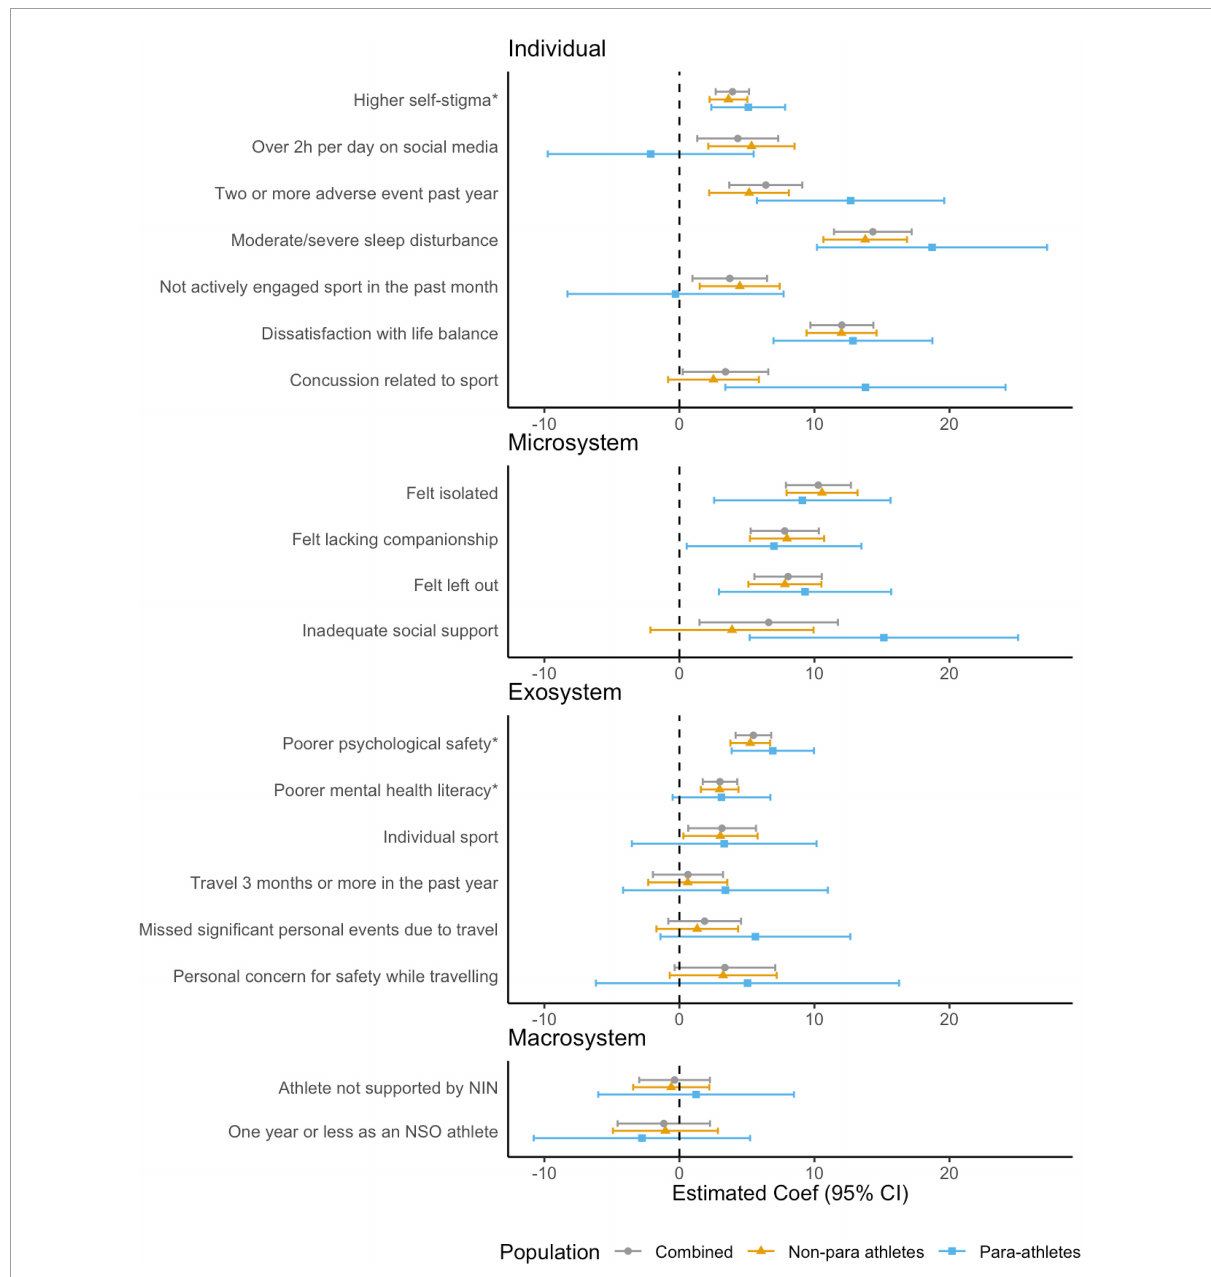
FIGURE1 Associations between risk factors and mental health symptoms (GHQ-28) for combined, non-para and para athletes, adjusted for age and gender. *Effects associated with one standard deviation ( SD ) change in Psychological Safety subscales (Low Self-Stigma, Mentally Healthy Environment, and Mental Health